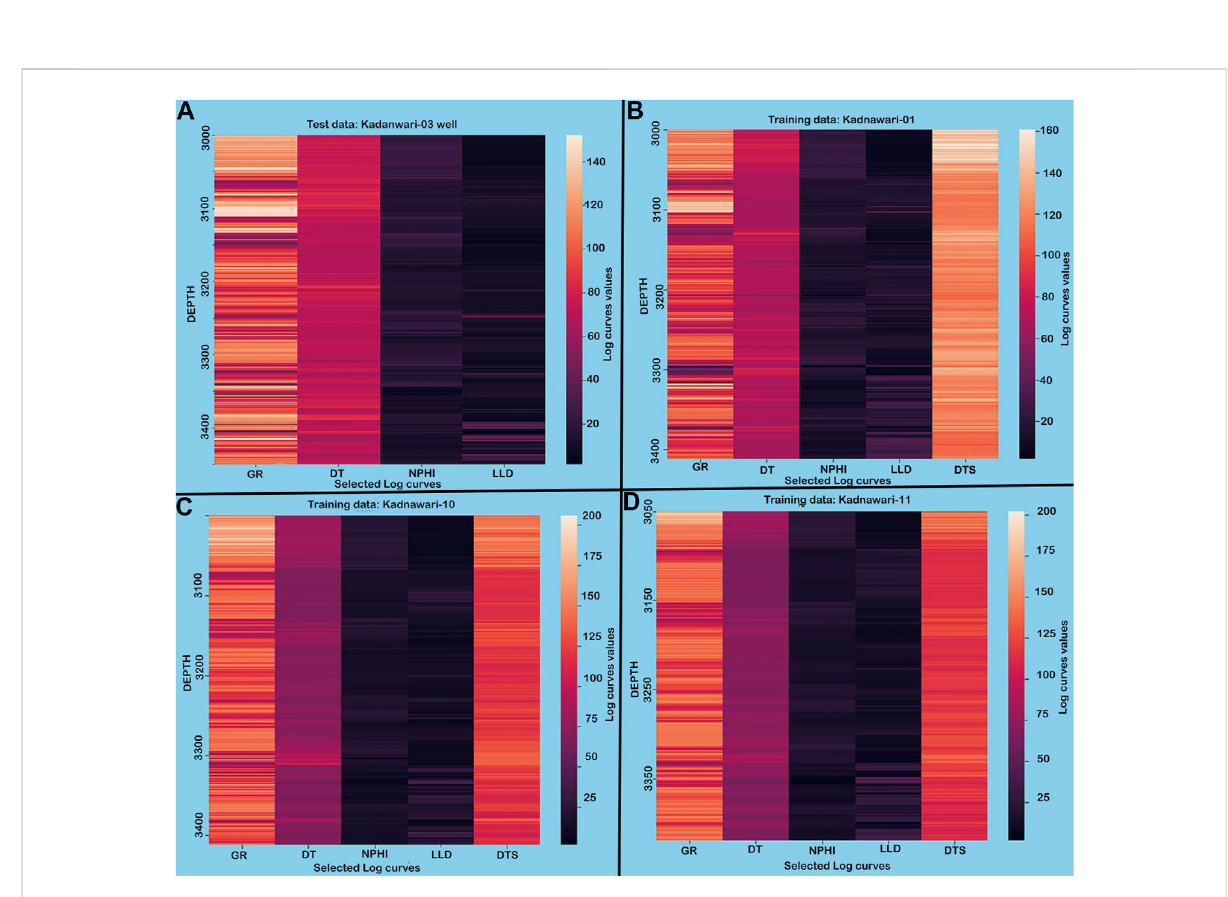
FIGURE 4 Heat map depicting values for selected logs against subsurface depth demonstrates that the data set is smooth and does not carry unrealistic values.